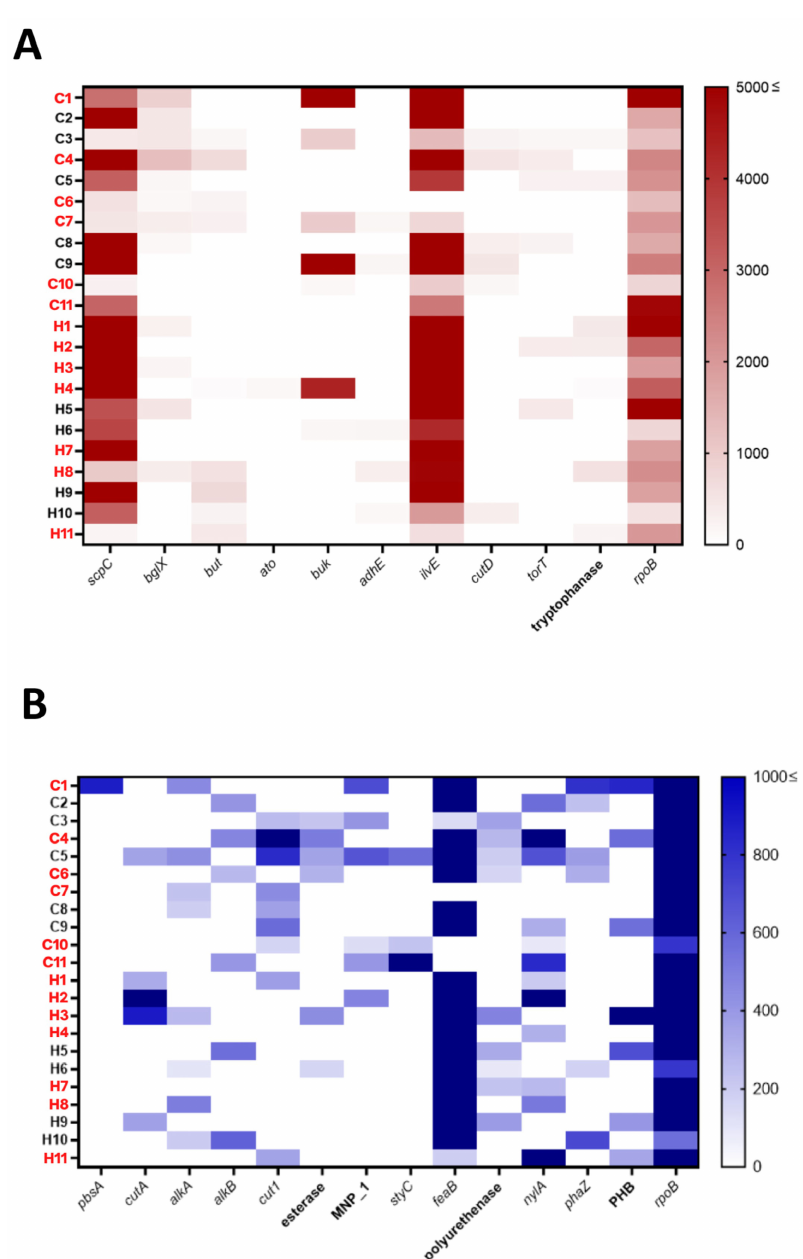
Figure 3. Target genes abundance in the populations contaminated with microplastics. Normalized read counts for ( A ) genes related to gut health and ( B ) genes encoding plastic-degrading enzymes with rpoB as housekeeping gene. Abbreviations of samples: C—Coastal, H—Highland, sample code in red represents individuals with microplastic contamination, while sample code in black represents individuals without microplastic